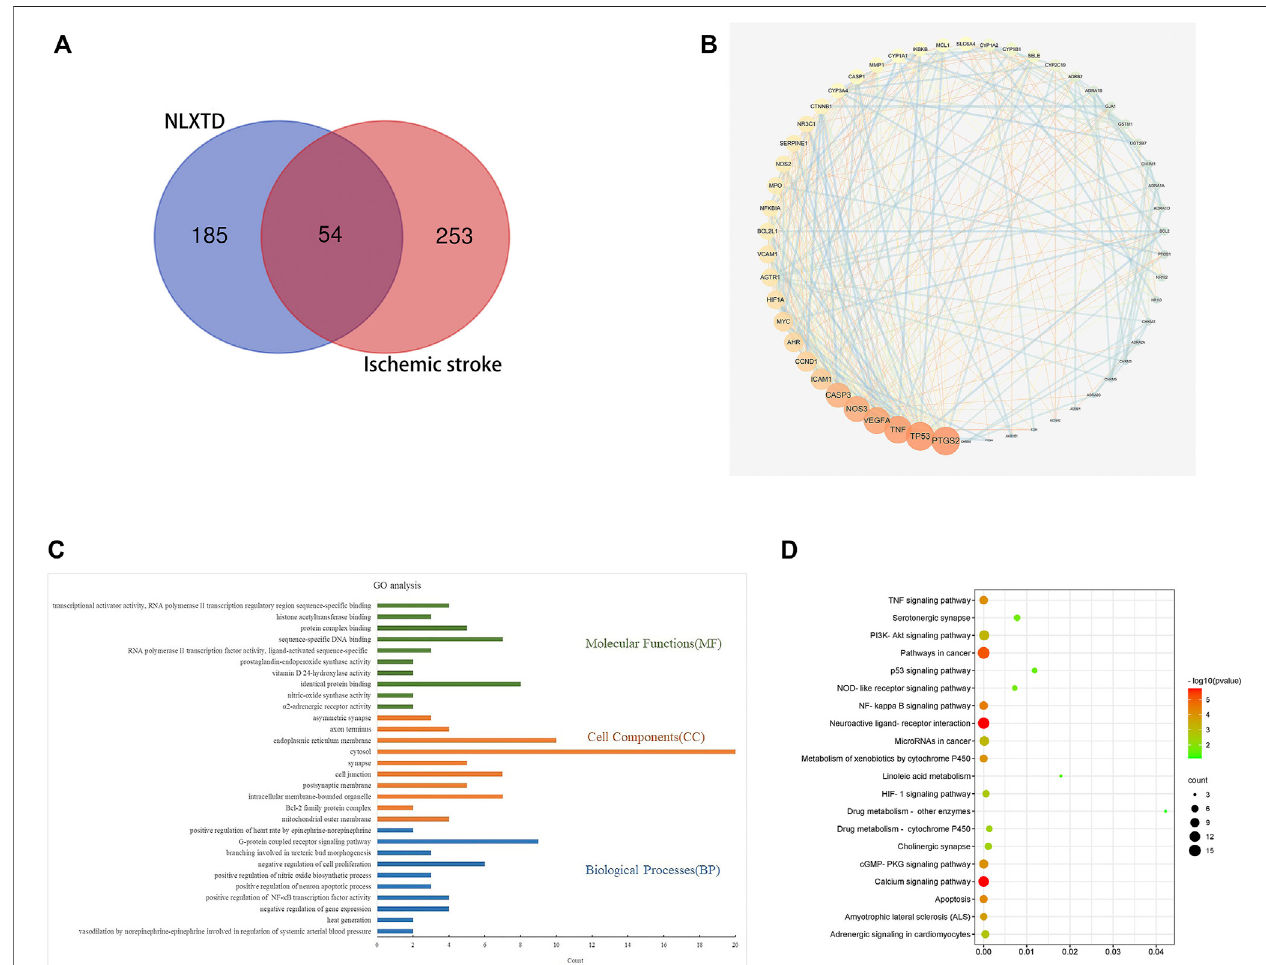
FIGURE 1 | VENN (A) , PPI network (B) , GO (C) , and KEGG (D) analysis of NLXTD.